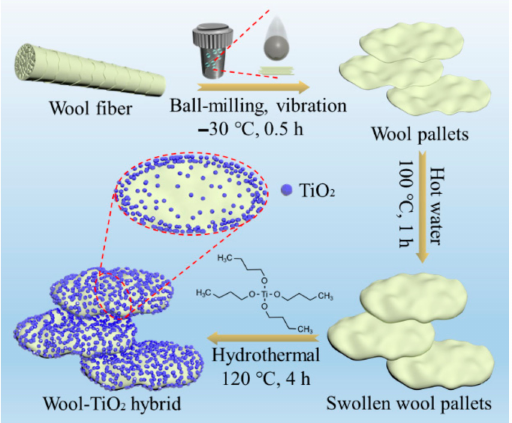
Figure 8. Schematic illustration for the fabrication of the WT hybrid composite